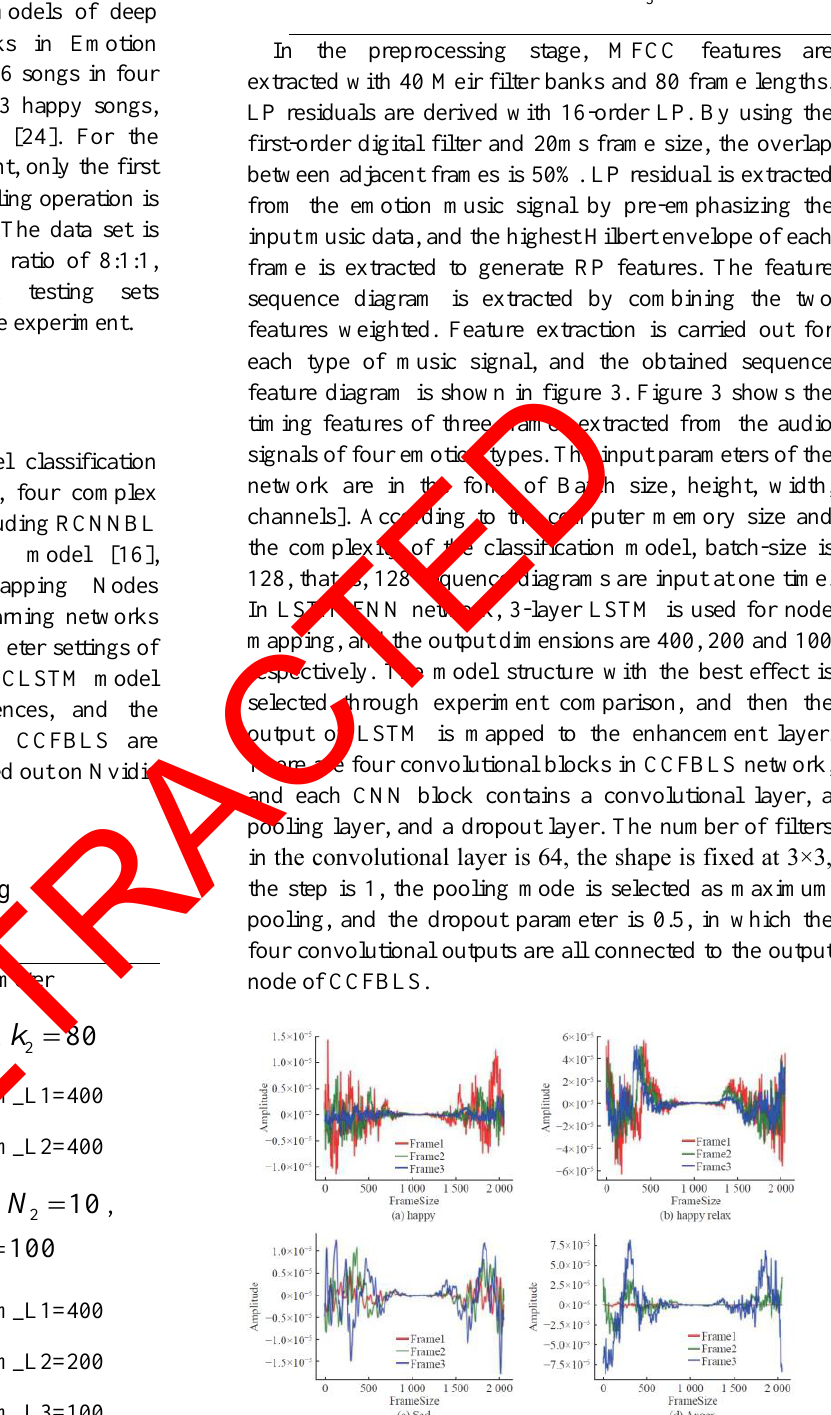
Figure 3. Timing features extracted from four music